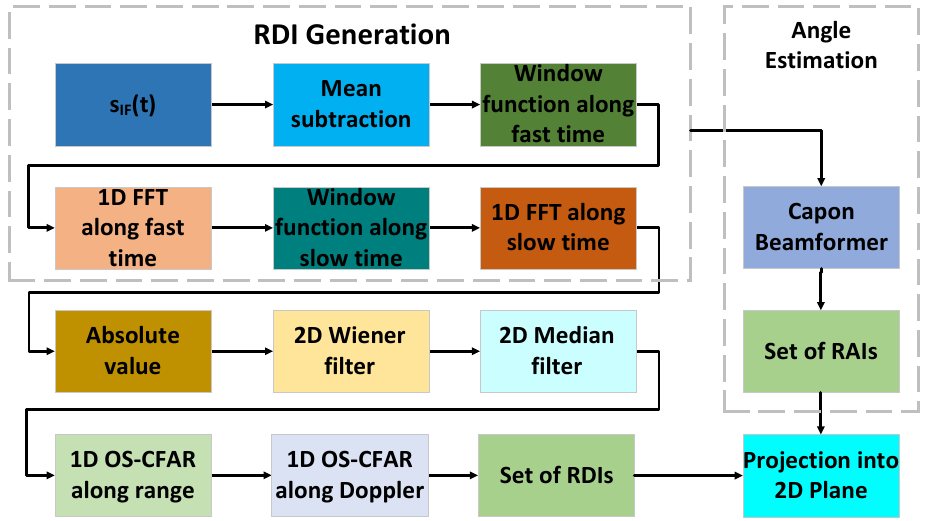
Figure 6 delineates the detailed generation scheme of range-time, velocity-time and angle-time images.